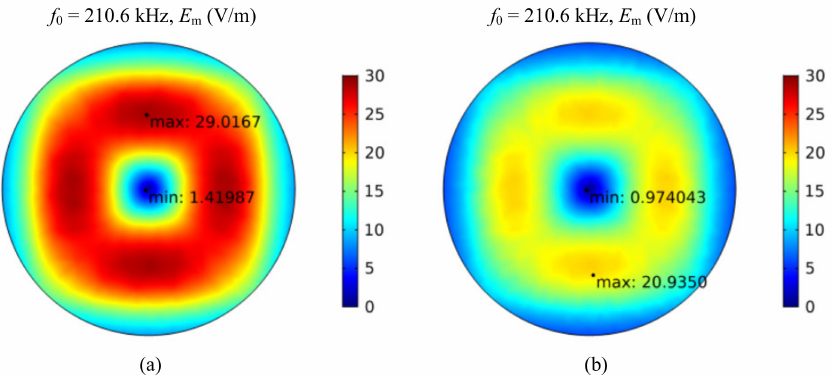
Figure 6. The electric field intensity magnitude of the IPT system. ( a ) SS topology; ( b ) SN topology.